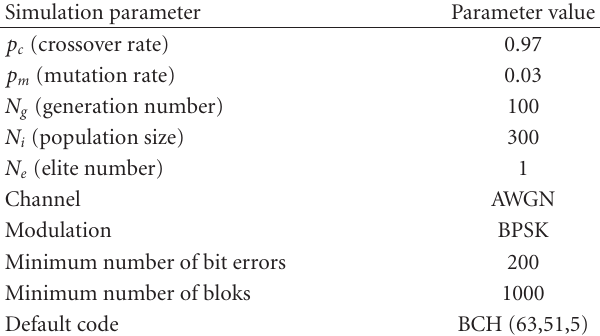
Table 2: Default parameters.